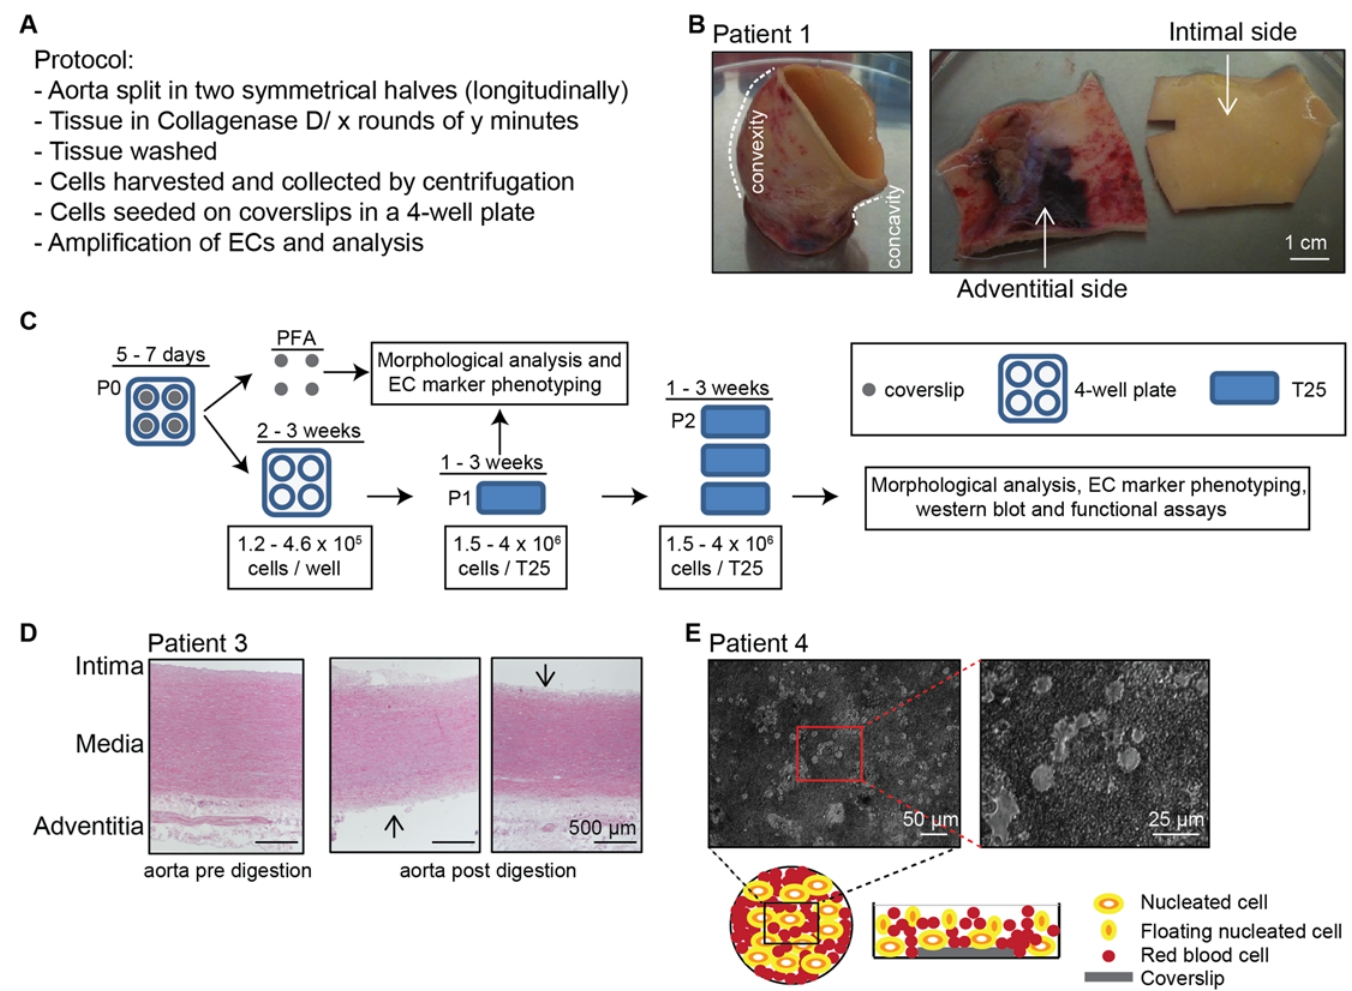
Fig 1. Overview of the sequential enzymatic digestion procedure for isolating cells from human aortic tissues. ( A ) The various steps of the isolation protocol are displayed. ( B ) A representative aneurysmal aorta segment is shown before and after longitudinal sectioning from its convex to its concave border. ( C ) A schematic diagram summarizes the fractionation procedure from the first round of enzymatic digestion (P0) to the expanded population (P2). ( D ) Histological analysis (H and E) of the representative aorta of patient 3, before and after collagenase digestion of the intimal or adventitial sides shows the efficiency of the enzyme action (4 rounds, 10 minutes each). ( E ) Phase contrast image of the crude cell population isolated after the first round of enzymatic digestion seeded in the 4-well plate (T0). Below left, a schematic representation of these cells seen from the top and from the side with the unattached cells floating in the culture